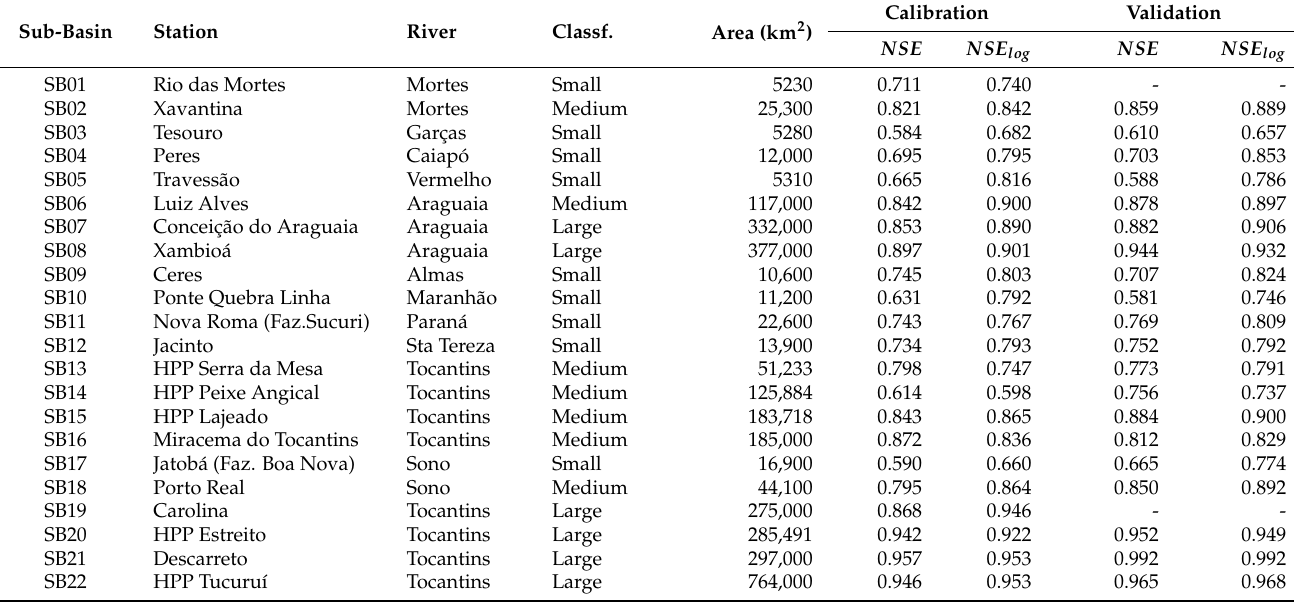
Table 1. Tocantins-Araguaia Basin characteristics and hydrological model calibration (2000–2010) and validation (2011–2014) periods in terms of NSE and NSE log